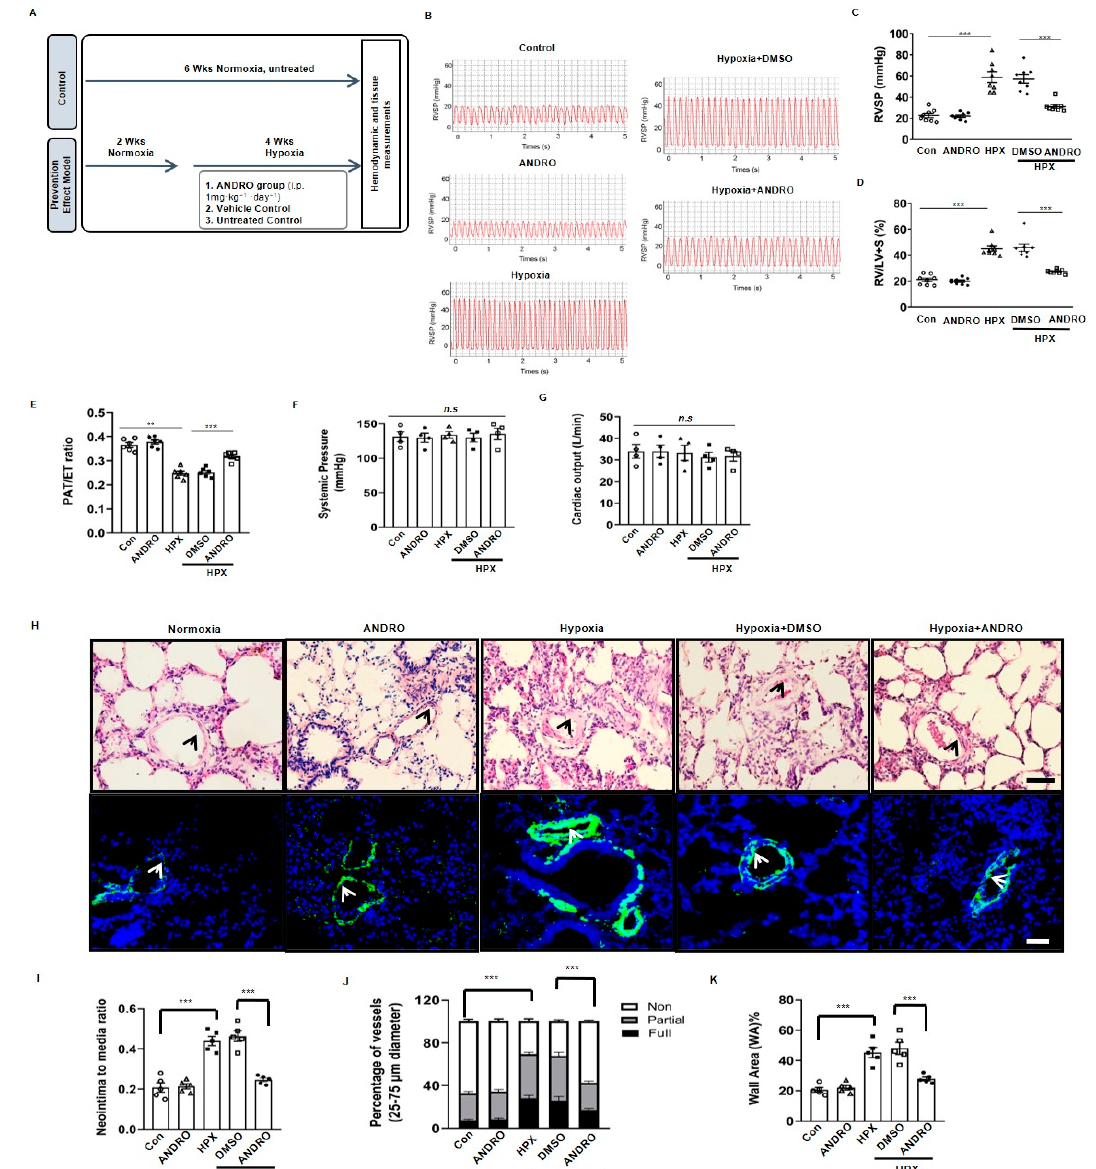
Figure 1. Andrographolide (ANDRO) prevented mice from hypoxia-induced pulmonary hypertension (PH). ( A ) Protocol of animal experiments. For hypoxia-induced PH model, mice were intraperitoneally injected with ANDRO (1 mg·kg − 1 ·day − 1 ) or a vehicle for two weeks followed by hypoxia for four weeks. Control mice were subjected to six weeks normoxia only. ( B ) Representative tracings showing the effect of ANDRO on pulmonary artery systolic pressure in hypoxia (HPX)-induced PH mouse model. n = 8. ( C ) ANDRO treatment significantly attenuated the elevated right ventricular systolic pressure (RVSP) in HPX-induced PH mice. Scale bars are 100 µ m. n = 8. ( D ) ANDRO reversed right ventricular hypertrophy in HPX-induced PH in mice assessed invasively by the right ventricular hypertrophy index (RV/LV+S). n = 8. ( E ) Echocardiography analysis showing the decreased PAT/ET in hypoxia-induced PH mice were reversed by ANDRO. n = 6. ( F , G ) ANDRO failed to affect systemic pressure ( F ) and cardiac output ( G ). n = 8. ( H ) Representative H&E staining (upper panel) and α -SMA immunofluorescence staining (lower panel) images showing the vascular remodeling in various groups. ( I ) Quantitative analyses showing that ANDRO significantly reduced the ratio of neointima/media. n = 5. ( J ) Quantitative assessment of pulmonary arterial muscularization. Non-, partially and fully muscularized arteries as a percentage of total alveolar wall and duct arteries were scored ( n = 5, one-way ANOVA for fully muscularized vessels). ( K ) ANDRO treatment significantly reduced the relative area of wall area (WA)%. n = 5. Data represent mean ± SEM. ** p < 0.01, *** p < 0.001. DMSO, Dimethyl sulfoxide; n.s.: no significant difference. Scale bars are 100 µ